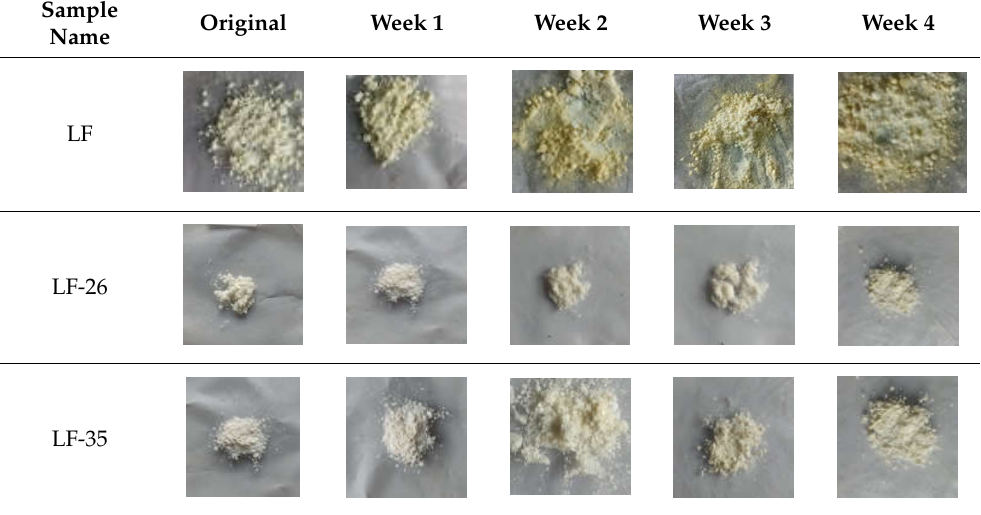
Table 2. Sample appearances during the test of stability towards UV lighting.